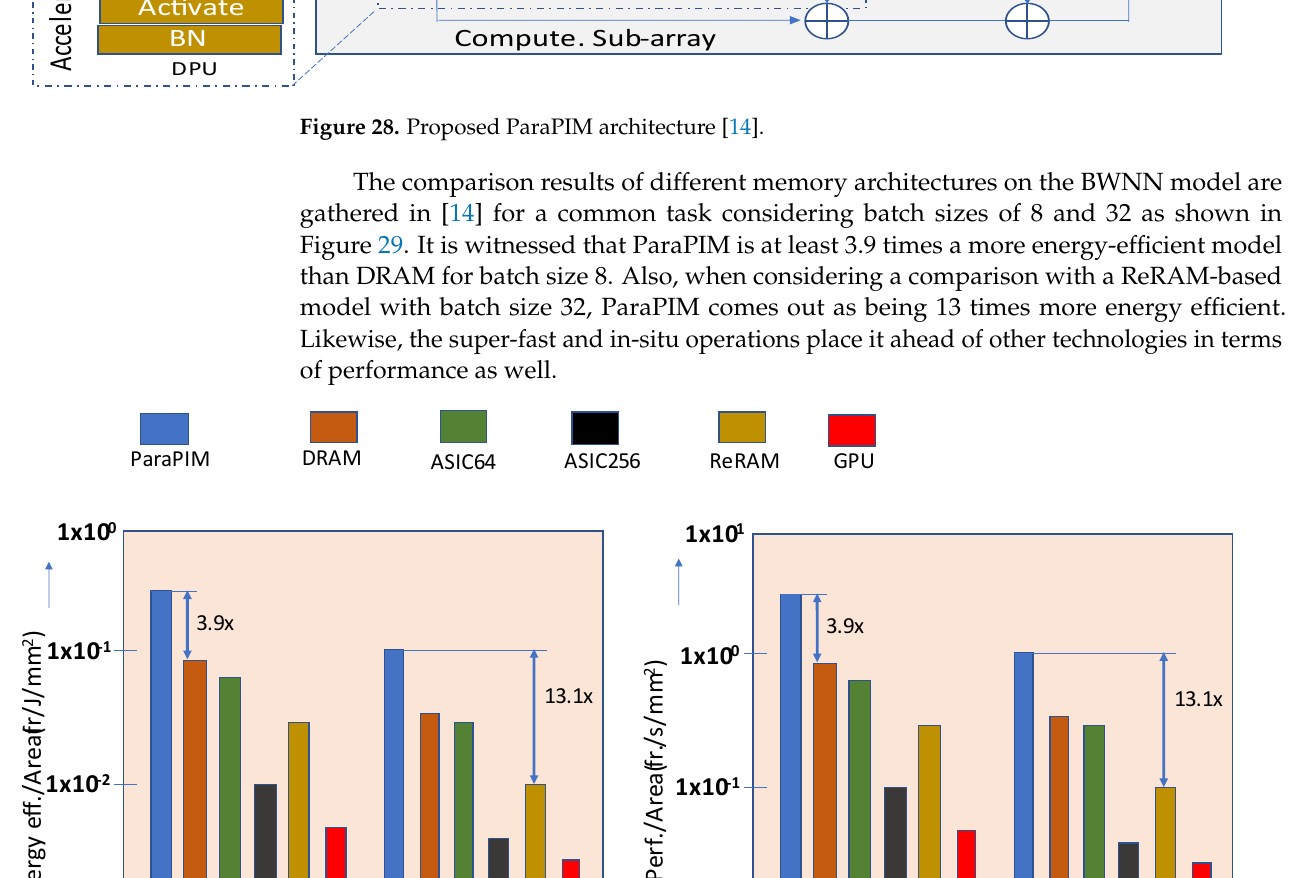
Figure 28. Proposed ParaPIM architecture [14].